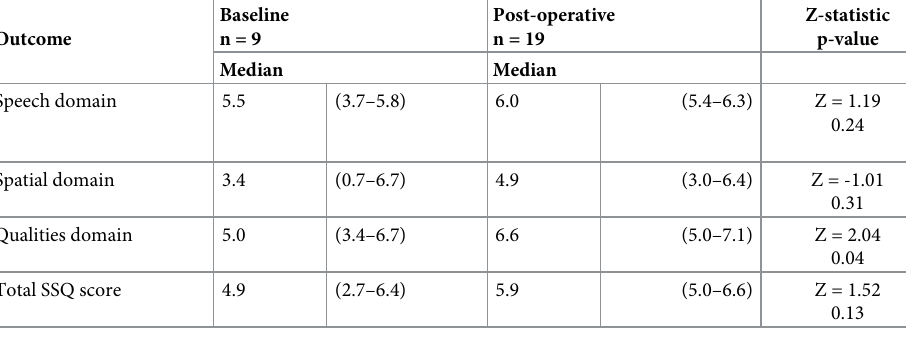
Table 3. Results of Speech, Spatial and Qualities of Hearing Scale (SSQ).